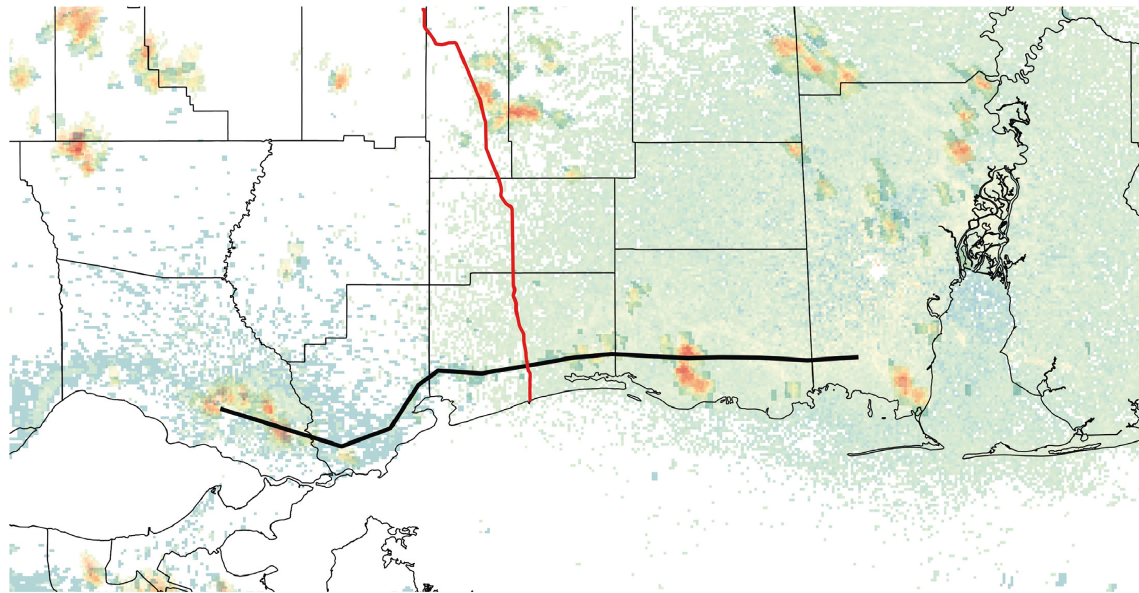
Figure 8: Radar reflectivity from KLIX and KMOB at 1840 UTC on 6 August 2014, with SBF fine line identified.